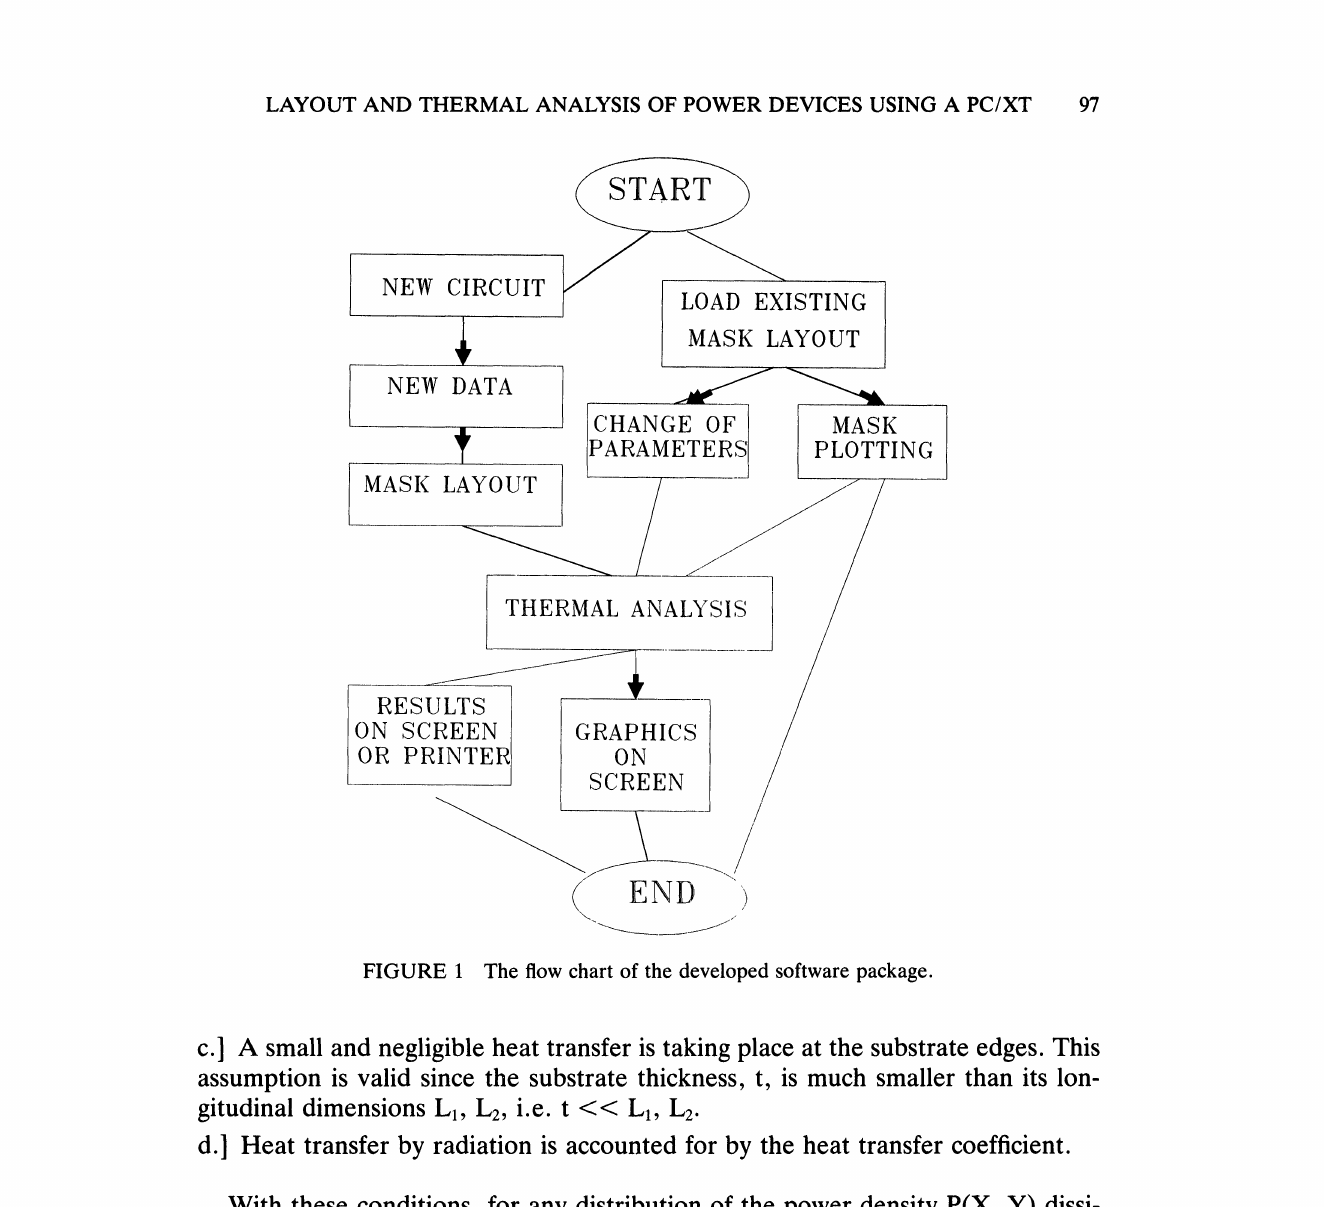
FIGURE The flow chart of the developed software